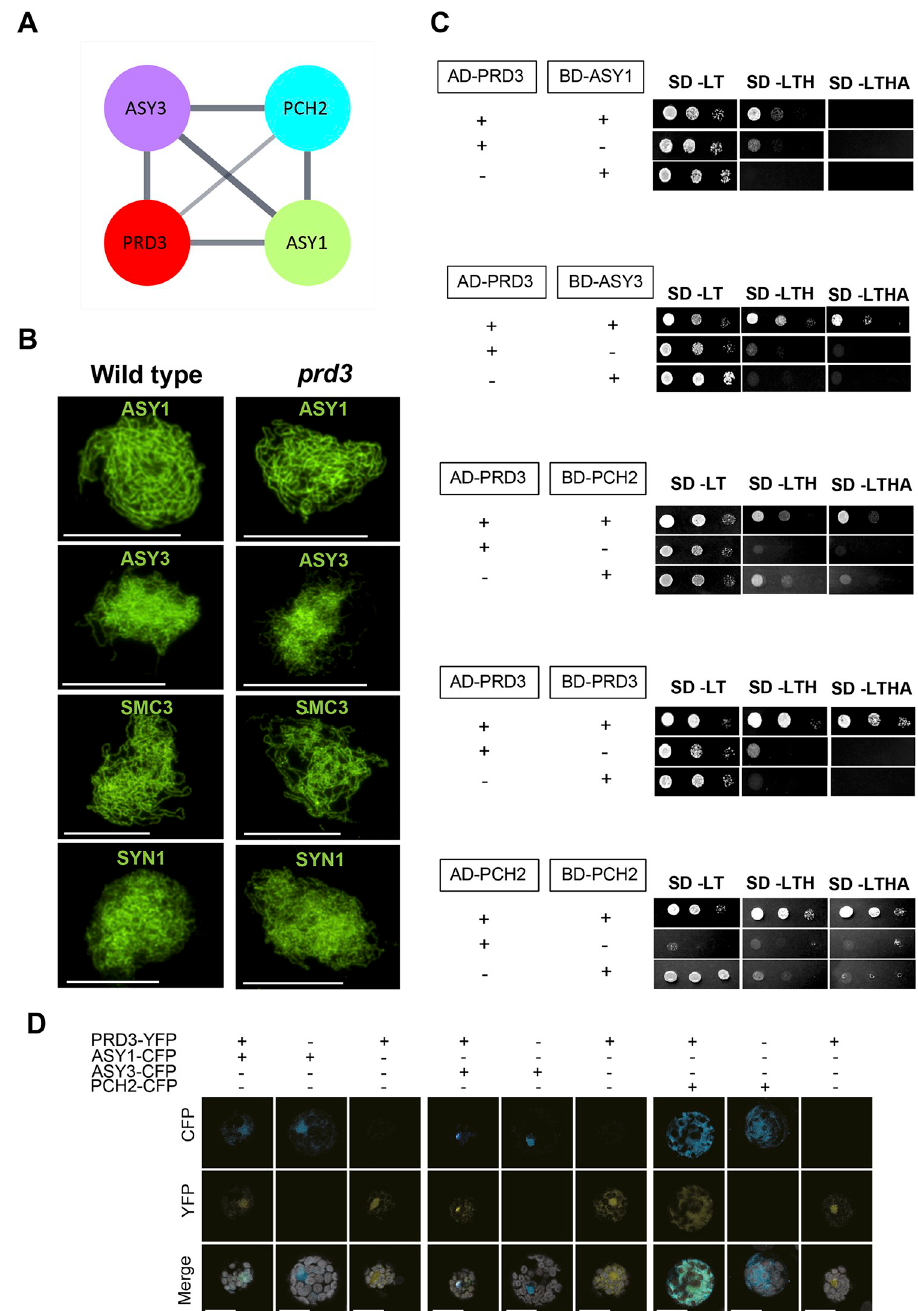
Fig 3. PRD3 interacts with components of the chromosome axis. ( A ) String protein association network showing the linkage between ASY1, ASY3, PCH2 and PRD3. The width of the string represents the strength of the association between the two proteins. ( B ) Immunostaining of ASY1, ASY3, SMC3 and REC8 in wild type and prd3 . Scale bars = 10 μ M. ( C ) Serial drop dilutions (undiluted, 1/10 dilution, 1/100 dilution) of yeast-two hybrid colonies grown on selective media to test the interaction between PRD3, ASY1, ASY3 and PCH2. “+” indicates presence of the Arabidopsis coding sequence in the AD - or BD -fused vector used for transforming yeast whereas “-”indicates absence of the Arabidopsis coding sequence in the AD - or BD -fused vector. SD-LT means synthetic defined medium lacking leucine and tryptophan and this medium selects for co-transformants yeast cells. SD-LTH means synthetic defined medium lacking leucine, tryptophan and histidine. SD-LTHA means synthetic defined medium lacking leucine, tryptophan, histidine and adenine. SD-LTH and SD-LTHA test for protein interaction under low- and high-stringency conditions, respectively. ( D ) Co-localisation assay of the fusion proteins PRD3, ASY1, ASY3 and PCH2 in